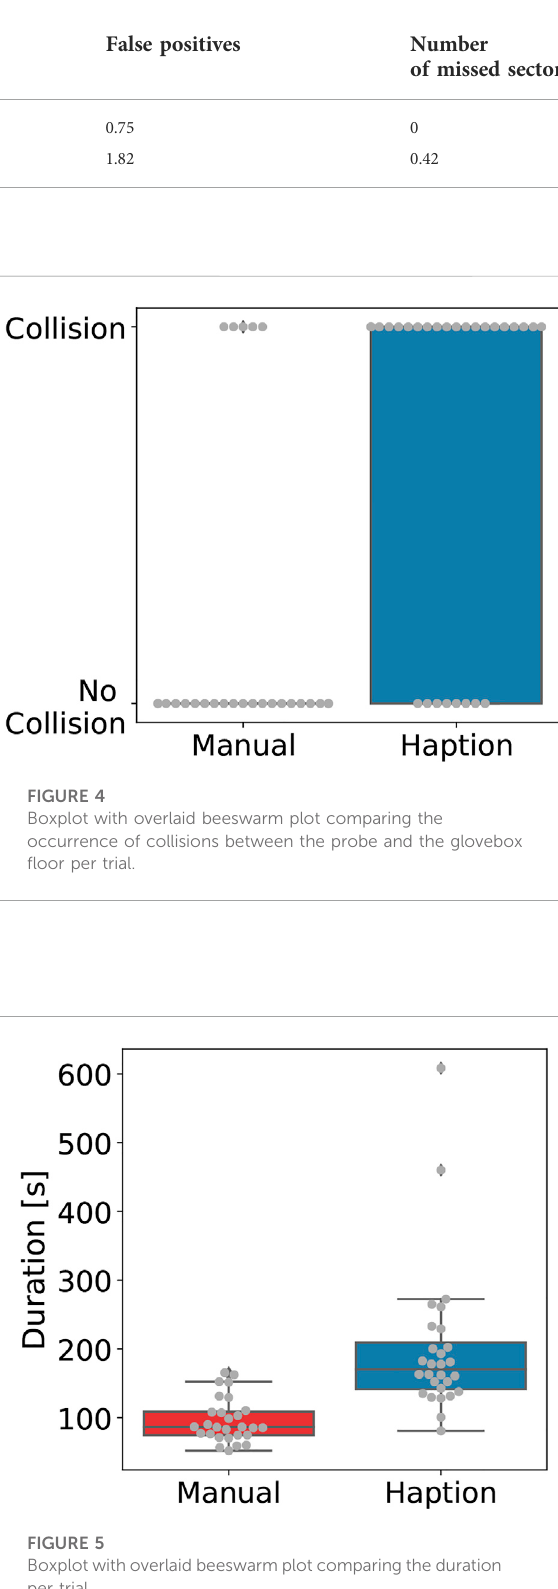
TABLE 1 Averaged performance metrics per manipulation method.